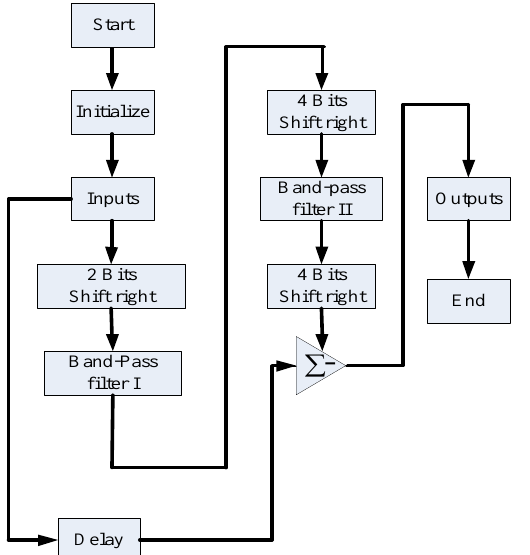
Figure 7. Software flow-chart for band-stop